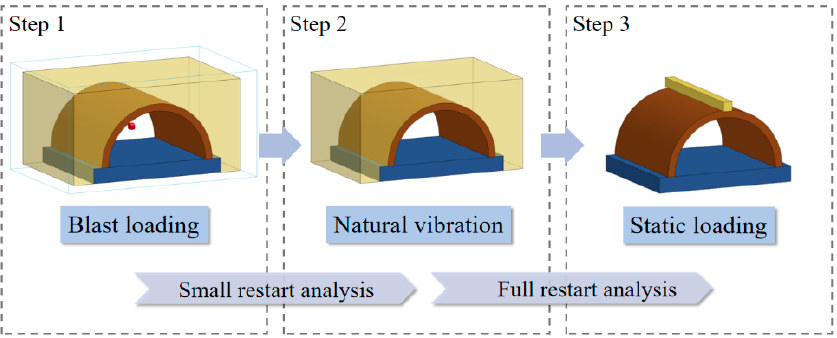
Figure 7. Process of calculation.